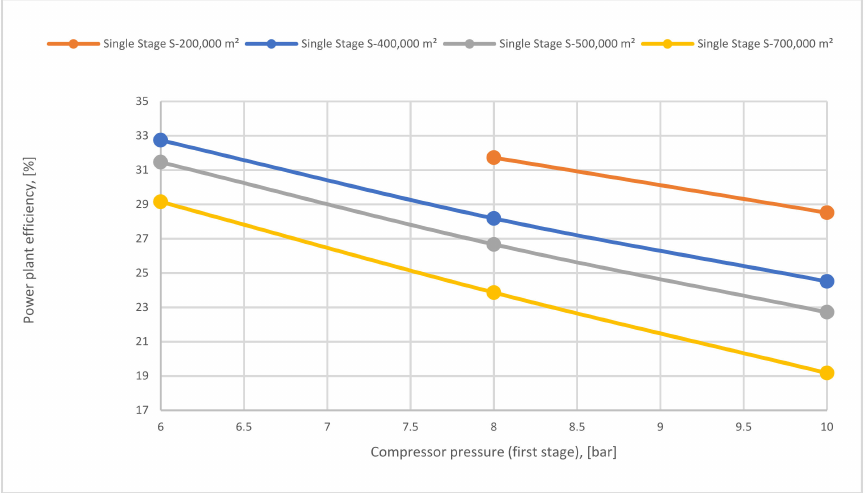
Figure 21. Power plant efficiency depending on 1st compressor pressure and different 1st membrane surfaces.